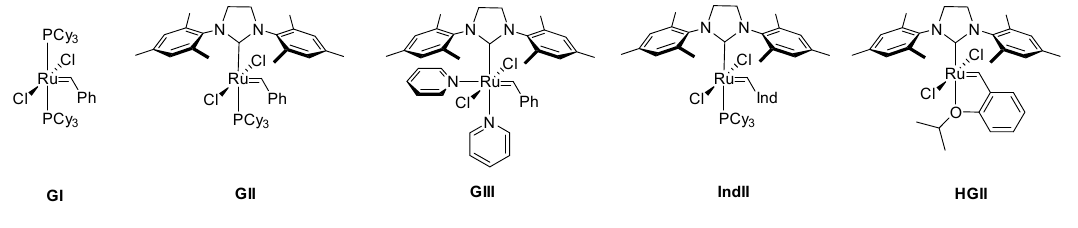
Figure 1. Common ruthenium metathesis catalysts.